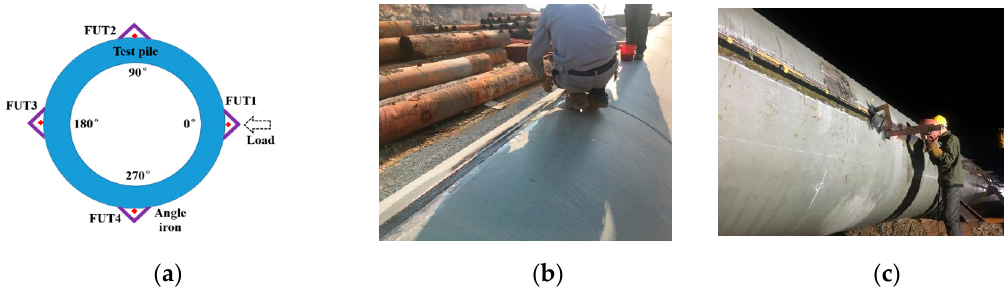
Figure 4. The detailed arrangement of optical fiber. ( a ) Arrangement and naming of distributed optical fiber sensors (DOFS) in the test pile; ( b ) adhering the DOFS with epoxy resin; ( c ) installation of angle steel for protective fiber.